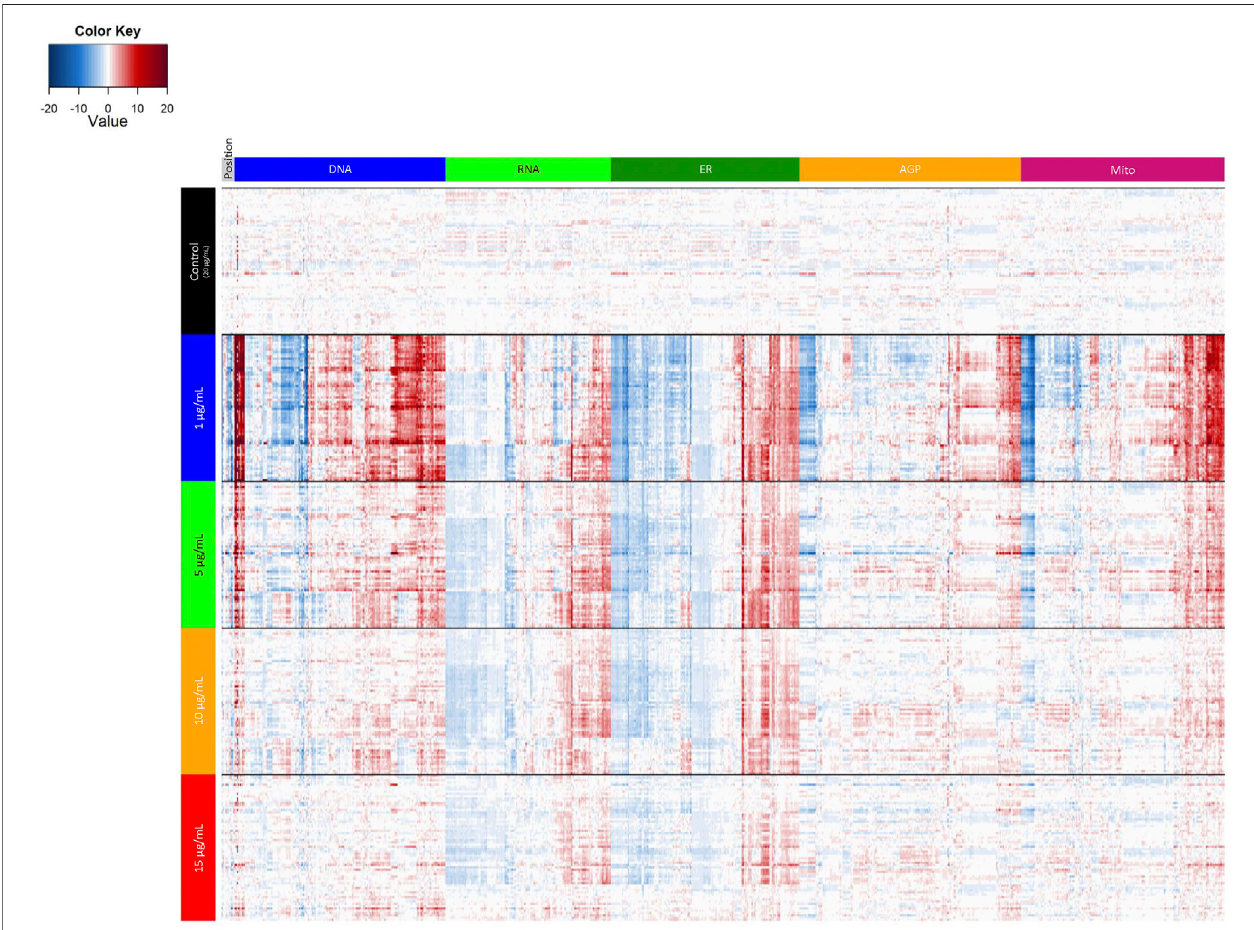
FIGURE4| Laminintiterheatmap.Cell-leveldatawereexportedtogeneratetheheatmapinRstatisticalsoftware.Datarepresentfourbiologicalreplicates(i.e.,independent cultures) which includes 16 technical replicates/concentration per biological replicate. The rows depict individual wells and are organized by laminin concentration; the columns depict individual features and are organized by channel. Heatmap coloring represents the size and direction of the phenotypic effect relative to 20 µg/ml (Control).